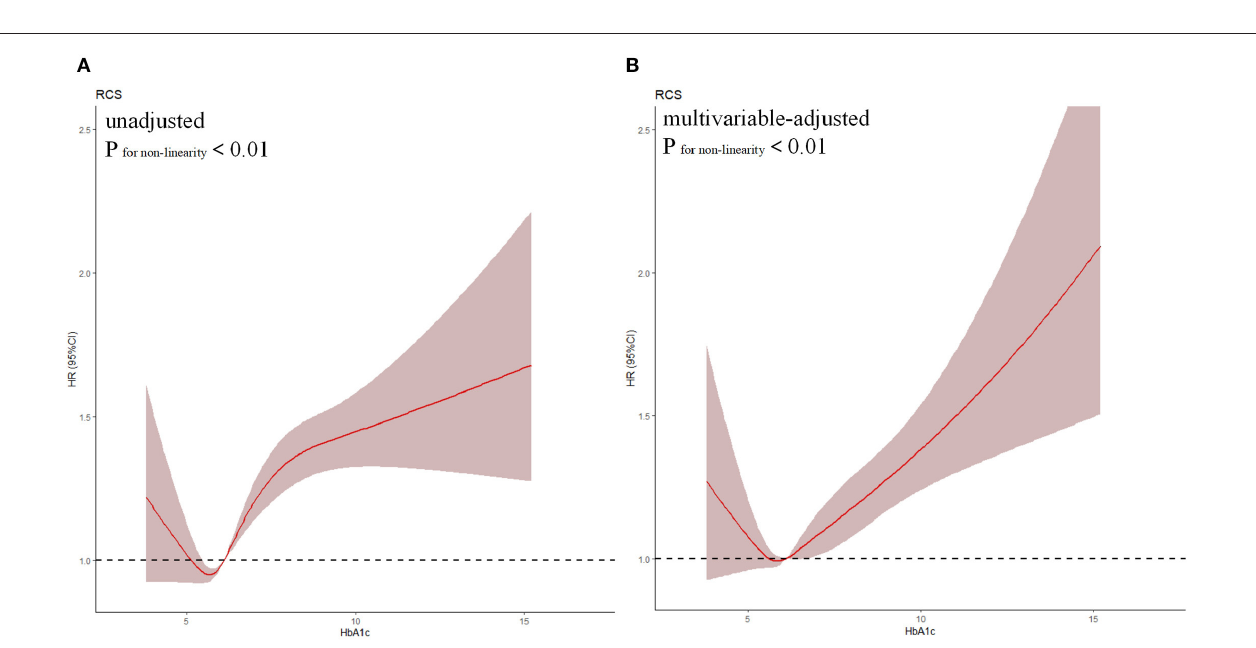
FIGURE 3 | Restricted spline curve of the HbA1c hazard ratio for mortality. (A) The restrict spline curve of univariate cox model; (B) The restrict spline curve of multivariate cox model, Adjusted for age > 75, gender, AMI, HT, pre-MI, PCI, eGFR, LDLC, URIC, Statin, ACEI/ARB.